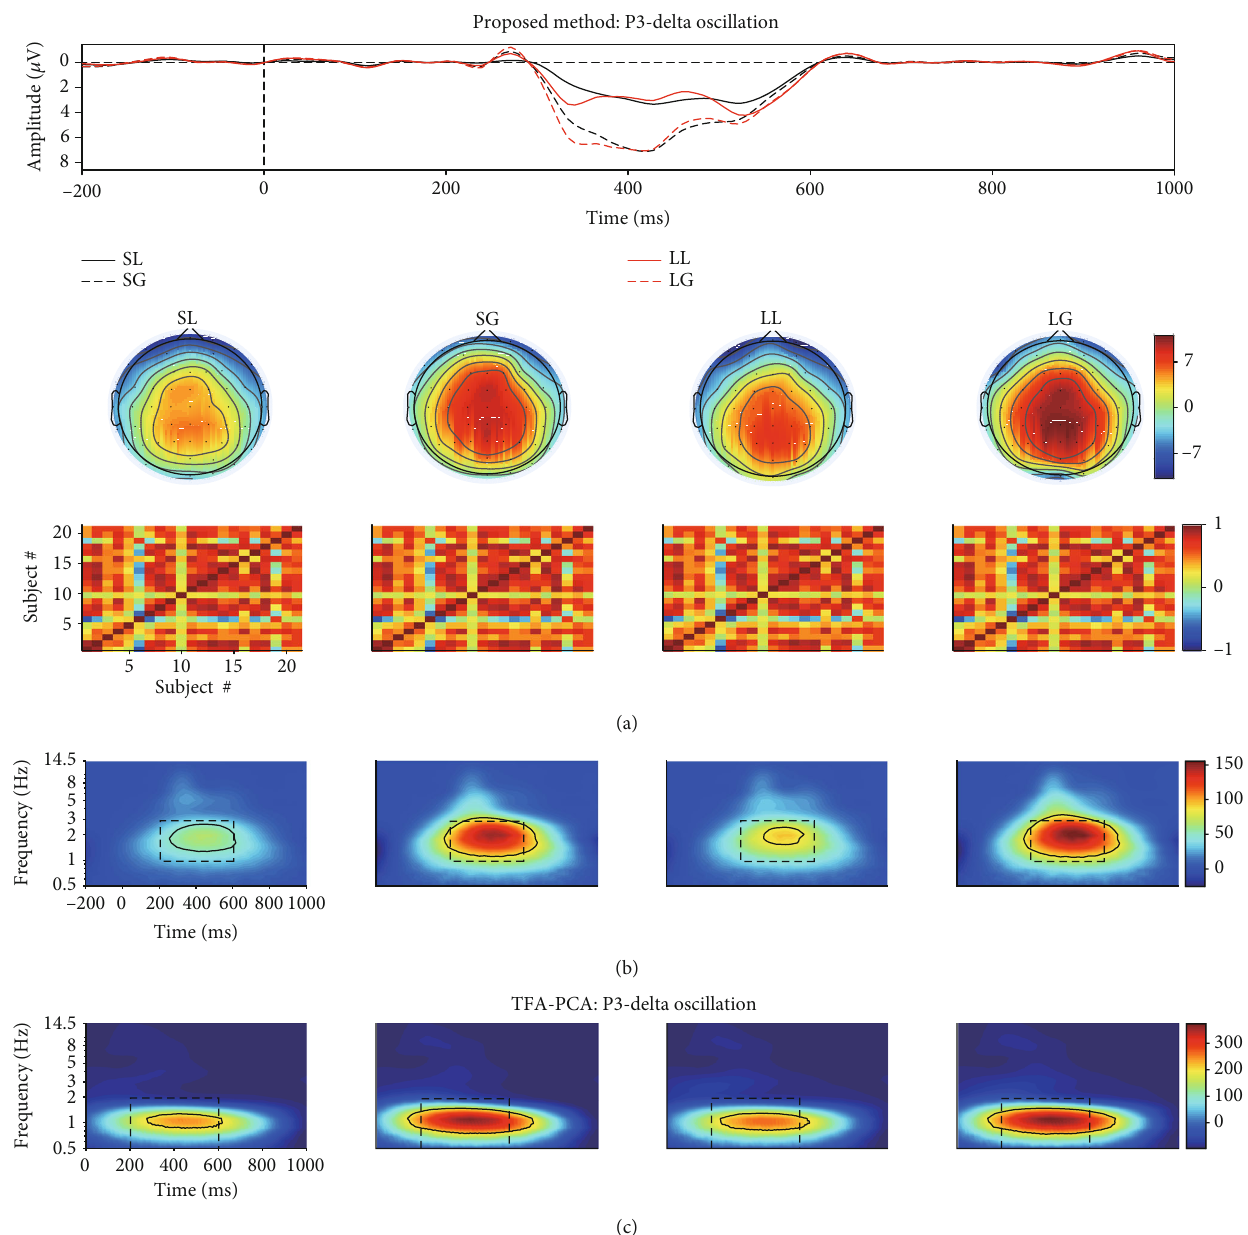
Figure 9: (a) The projected waveform (at Fz, FCz, Cz, CPz, and Pz electrodes), topography (300-600ms), and similarity of topographies across participants of every condition for N2 which were extracted from the real mixed signal using proposed approach. (b) The associated grand averaged time-frequency representation (TFR) of every condition. The black dotted rectangle (the time window was 200- 600ms, and the frequency range was 1-3Hz, “ R10 ” ) for every condition was marked using the conventional rectangle method, and the other ( “ R11 ” ) was gained by the edge detection algorithm. (c) The weighted TFRs of P3-delta oscillation when using TFA-PCA. The black dotted rectangle was 200-600 ms and 0.5-2 Hz ( “ R12 ” ), and the other one ( “ R13 ” ) was gained by edge detection